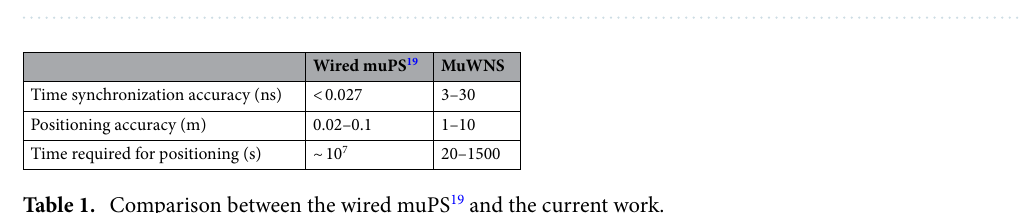
Table 1. There are two distinctive differences between these techniques which relate to the following 2 issues: (A) the time synchronization accuracy and (B) the time required for positioning. A picosecond level synchroniza- tion accuracy can be achieved with the wired technique. Thus, wired muPS has no time-dependent positioning drift and thus, centimeter level precise positioning measurements are possible with sufficiently long (timescale) measurement periods. However, since the reference detectors and the receiver detector are connected with a physical cable, the mobility of the receiver detectors is restricted; hence wired muPS generally cannot be used for the purpose of navigation. On the contrary, while the wireless technique can be applied to mobile experi- ments, due to unexpected frequency drift coming from the local clock, the positioning accuracy is degraded.